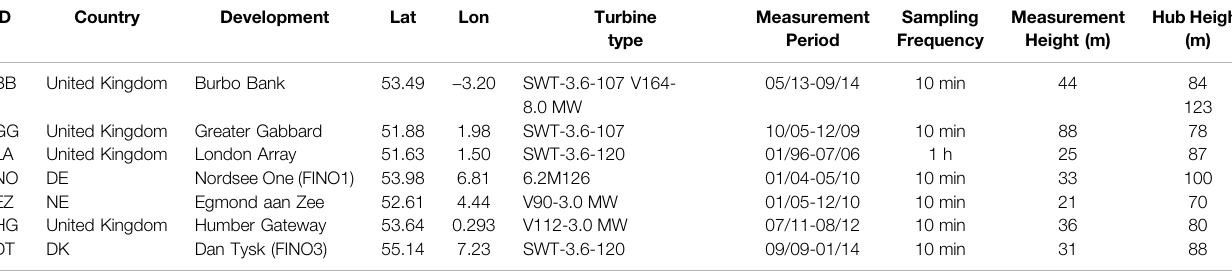
TABLE 1 | List of the in-situ observations used and characteristics of the wind speed time series at the analyzed offshore wind